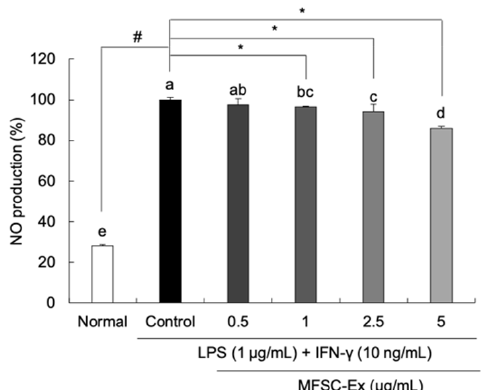
Figure 2. Effect of MFSC-Ex on NO production in LPS/IFN- γ -stimulated RAW 264.7 macrophage cells. Cells were treated with various concentrations of MFSC-Ex (0.5, 1, 2.5, 5 µ g/mL) for 2 h, followed by LPS (1 µ g/mL) and IFN- γ (10 ng/mL) for 24 h. Values are expressed as means ± SD. a–d Means with the different letters are significantly different ( p < 0.05) by Duncan’s multiple range test. # p < 0.05 vs. normal (un-treated) group, * p < 0.05 vs. control (LPS/IFN- γ -treated) group.